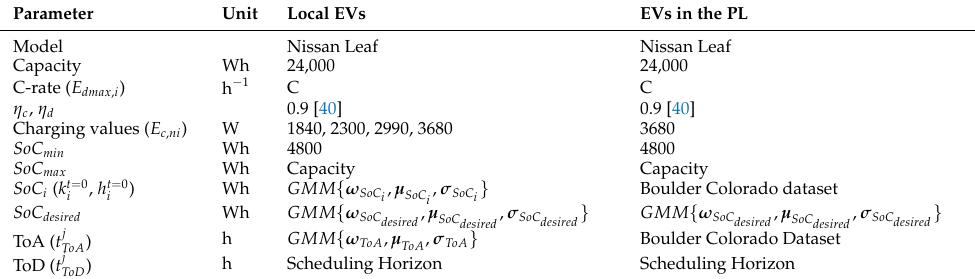
Table 7. EVs parameters.